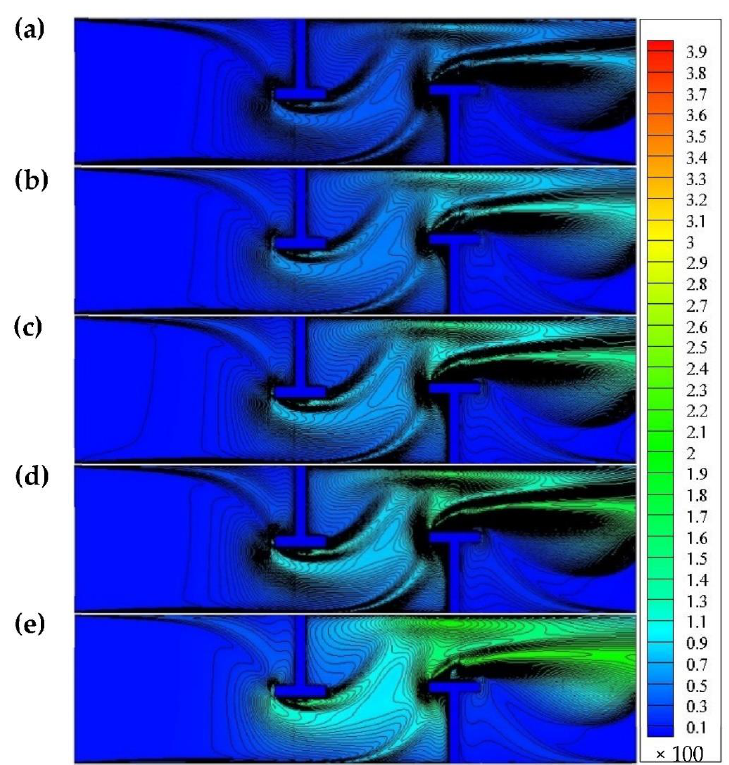
Figure 10. Turbulent intensity vs. flow rate: Re = ( a ) 12,000; ( b ) 17,000; ( c ) 22,000; ( d ) 27,000; ( e ) 32,000.